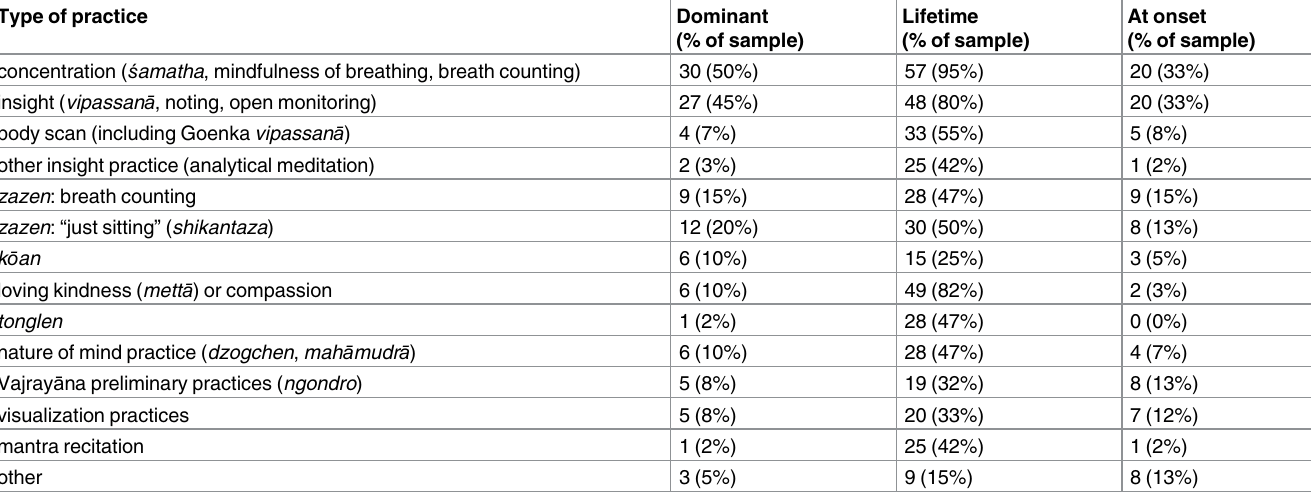
Table 2. Types of meditation